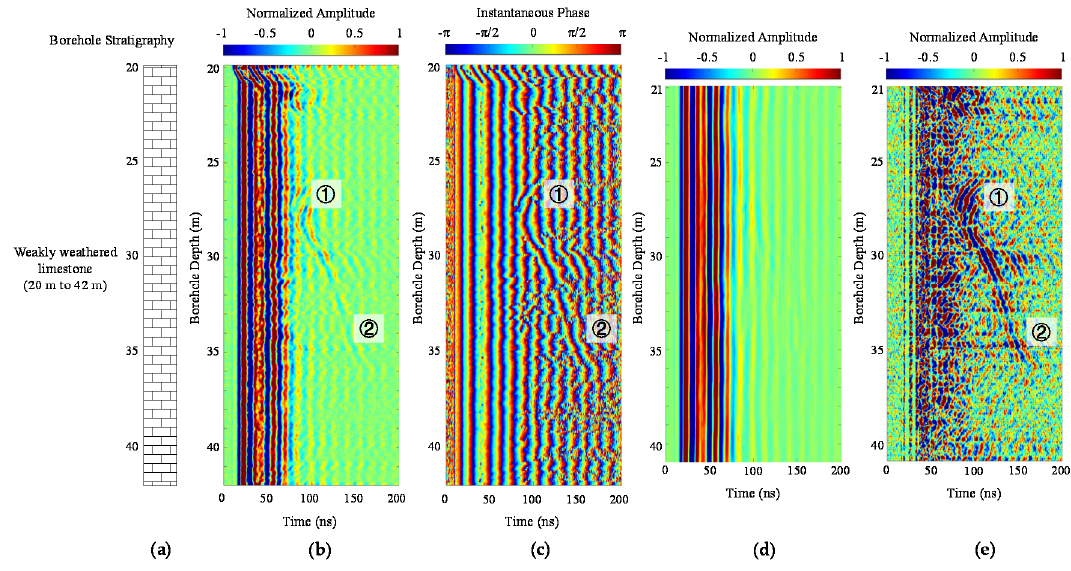
Figure 8. Single borehole GPR detection data on a typical rock fracture borehole scenario. ( a ) No. ZK-7-13 borehole stratigraphy; ( b ) radar data; ( c ) instantaneous phase; ( d ) removed wave profile using median filtering; ( e ) median filtered wave.